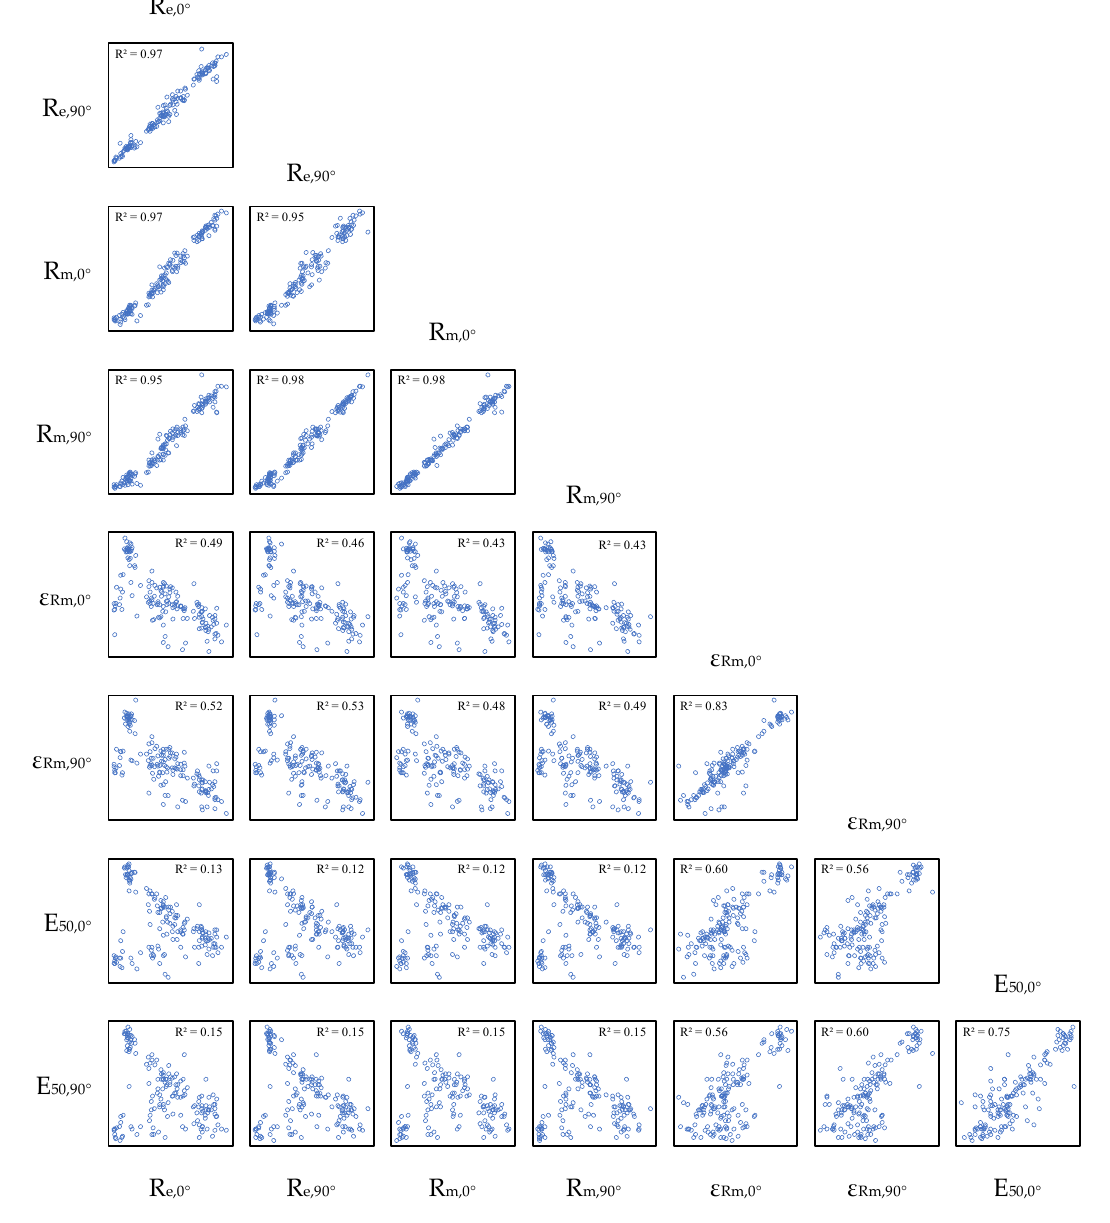
Figure 1. Representation of the relationships between the obtained tensile test results, defined in Table 1. The samples used for the hole expansion tests (HET) had an initial hole diameter of 20 mm, the burr was positioned in the freely expanding side during the HET and the tests were carried out up to values of punch displacement that ensured the fracture of all samples. The result obtained from these tests is the logarithmic circumferential (hoop) strain at fracture, ε f . Figure 2 shows the distribution of logarithmic strain values at fracture obtained for the hole expansion tests.